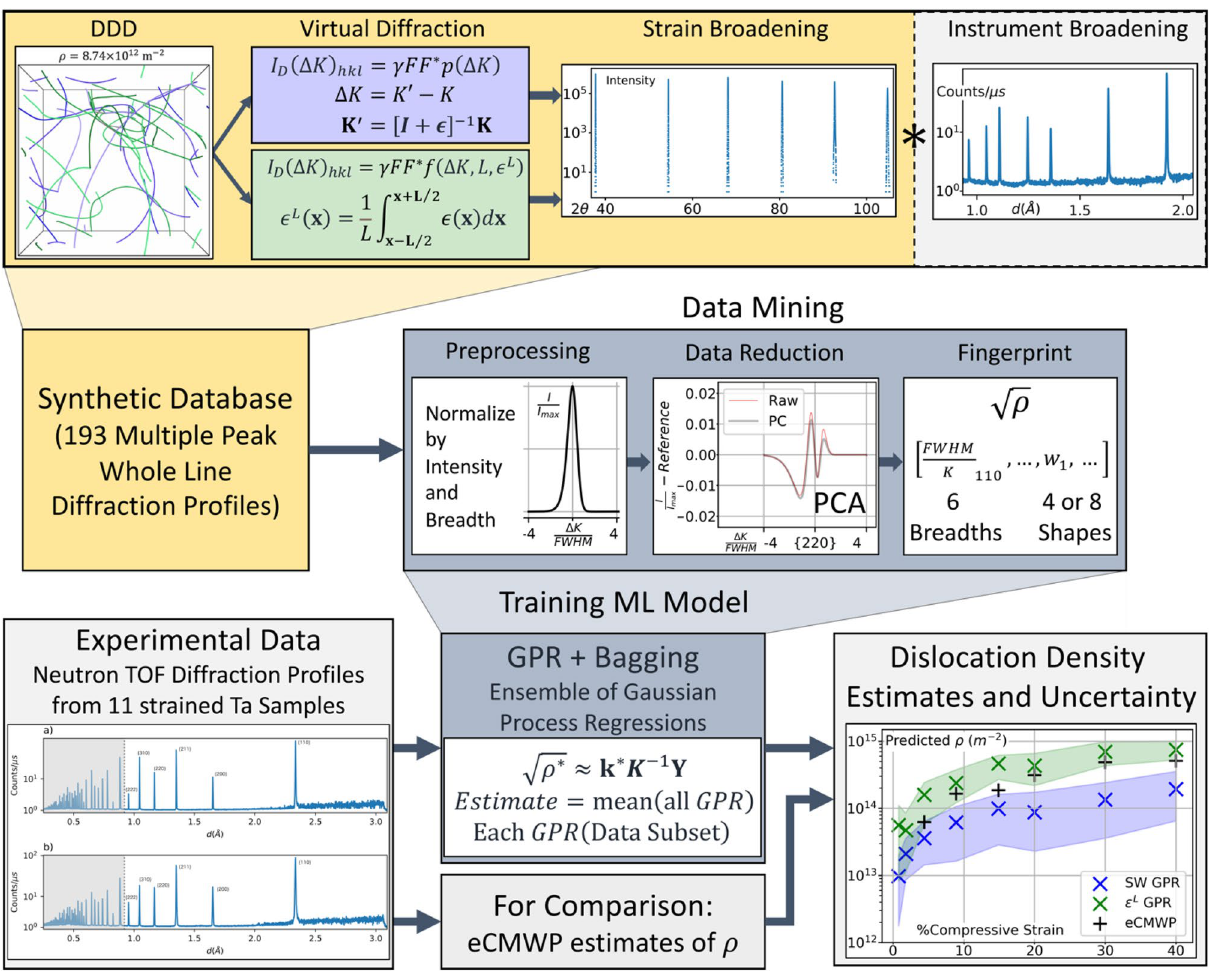
Figure 1. The general outline for the approach, beginning with the synthetic database generation, with discrete dislocation dynamics and virtual diffraction algorithms to calculate strain broadening, combined with instrument broadening obtained from calibration experiments. The data mining procedure is shown, including preprocessing steps, the data reduction using principal component analysis (PCA) and resulting in a fingerprint to be used in a machine learning (ML) model. Lastly, the use of the ML model is shown as a comparison with an existing method (eCMWP) in the prediction of dislocation density from experimental neutron diffraction profiles of deformed Ta